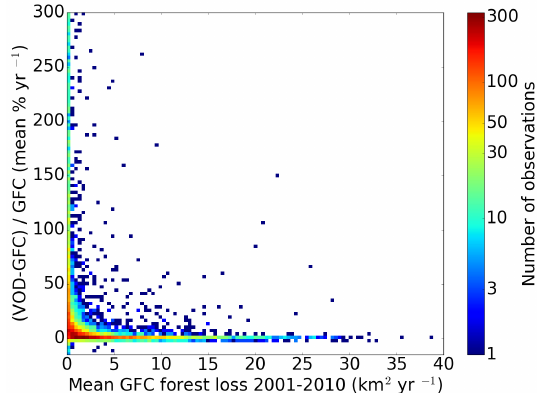
Figure 5. Error as a function of mean GFC forest loss, where the error is defined as VOD minus GFC forest loss area as a percentage of GFC for the overlapping time